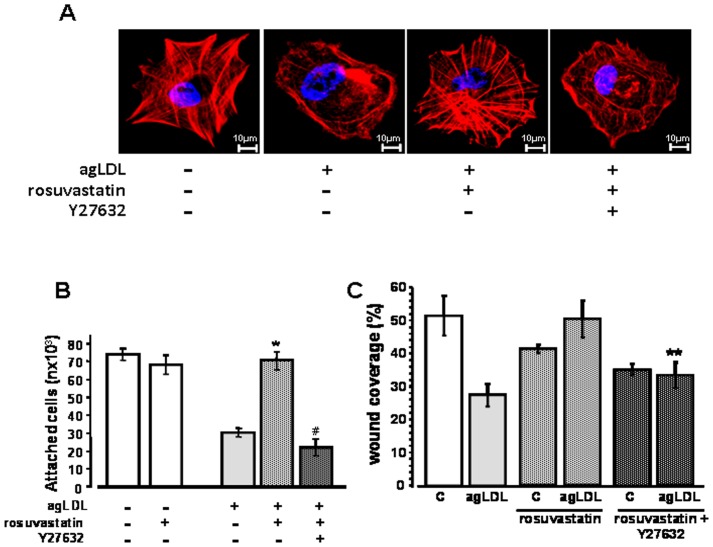
Rosuvastatin induced actin-cytoskeleton reorganization, cell adhesion and migration in agLDL-VSMC is dependent on the RhoA/ROCK signaling pathway.agLDL-VSMC incubated with rosuvastatin in absence/presence of inhibitors for ROCK (Y27632) or MLCK (ML9) were analyzed for (A) filamentous actin organization during cell attachment. Note that rosuvastatin-promoted filamentous actin organization in LDL-VSMC was prevented by Y27632 (B) cell attachment (expressed as percentage of the control group) (*) vs agLDL and (#) vs agLDL+ rosuvastatin group, p<0.01 (Mann Whitney test). (C) wound repairing (*) vs agLDL p<0.01 (Mann Whitney test) and (#) vs agLDL+ rosuvastatin group, p<0.01 (Mann Whitney test). In B and C, bar diagrams represent the mean±SEM of 3 independent experiments.